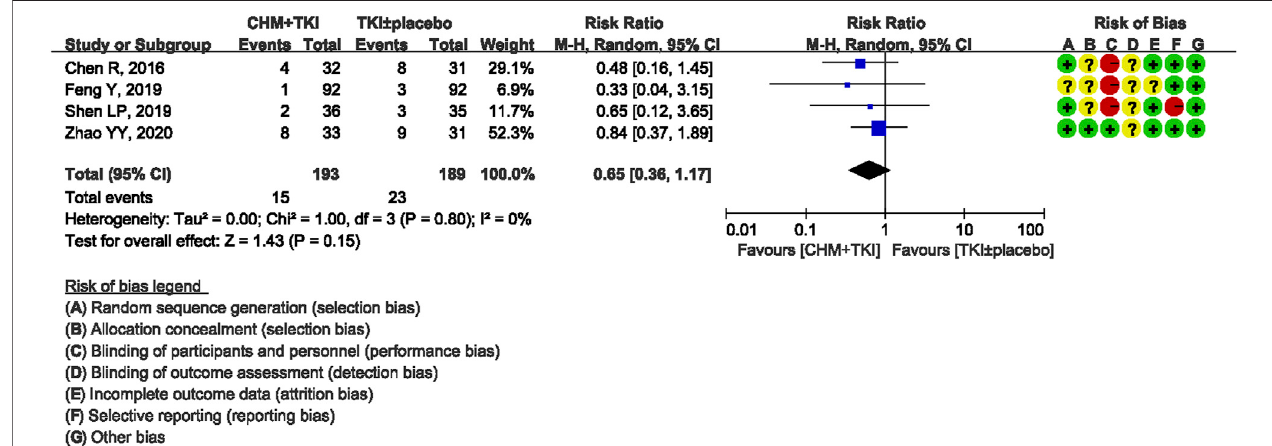
FIGURE 8 | Forest plot for incidence of hepatic dysfunction.